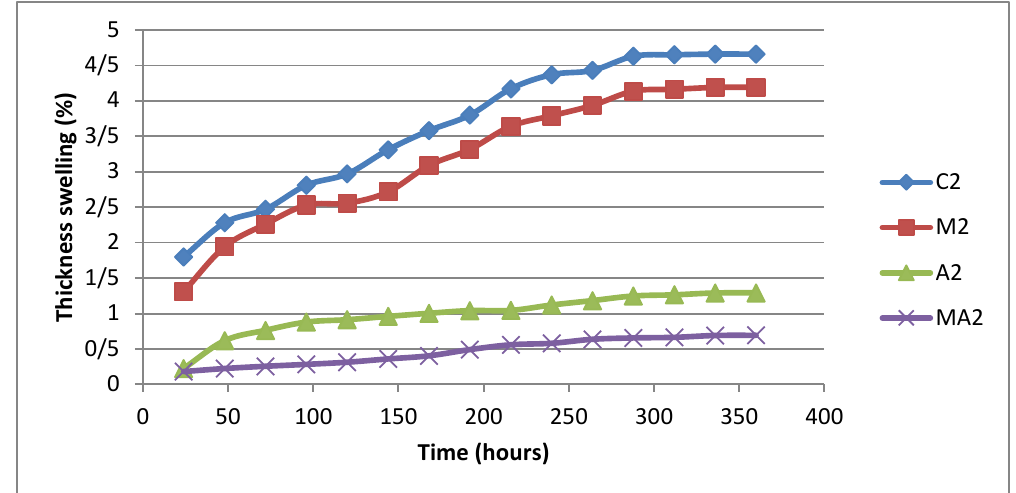
Fig. 9. Comparison of thickness swelling, among various treatments, due to moisture absorption for P2 fibre contents.